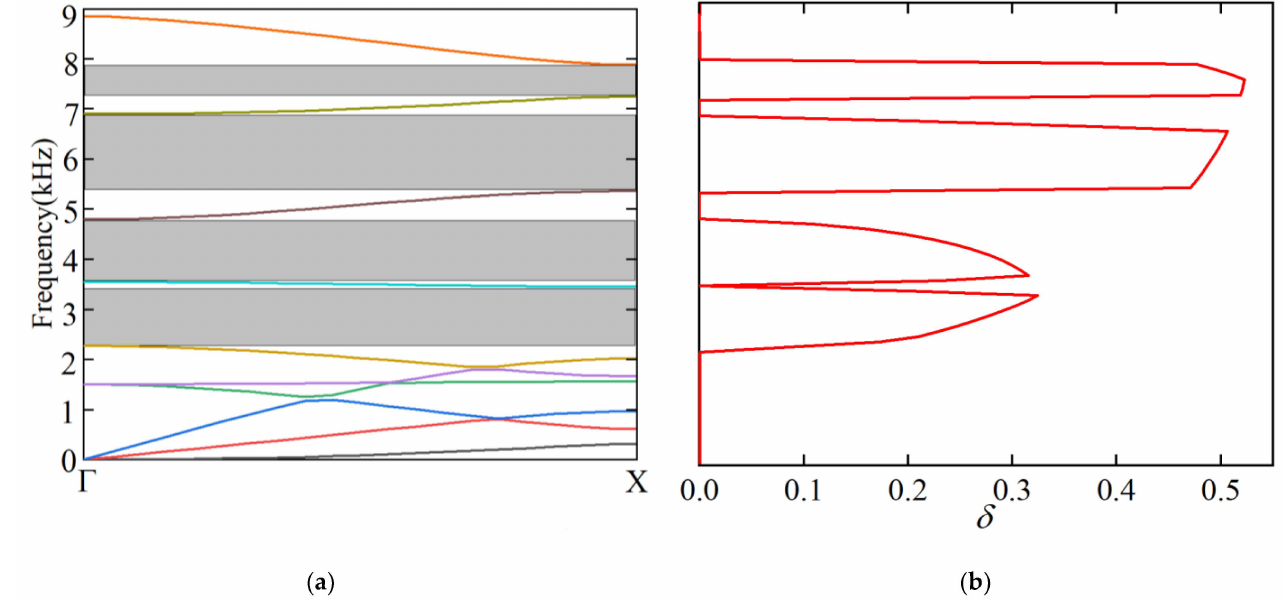
Figure 7. ( a ) Band structure in the Γ X direction; ( b ) Attenuation constant in the Γ X